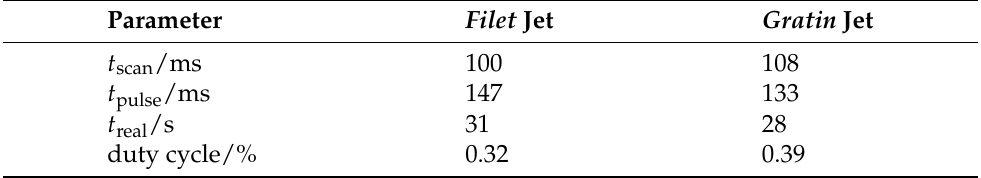
Table 5. Comparison of relevant parameters of the FTIR measurements and the pulsed operation at the filet and gratin jets. t scan : Scan-time (time for data acquisition) of the IR spectroscopic (sample) measurement per pulse; t pulse : duration of the gas pulse; t real : real-time needed for a complete cycle of gas pulse, measurements, and waiting time between gas pulses; duty cycle: time used for measurements with respect to total time per cycle ( t scan / t real